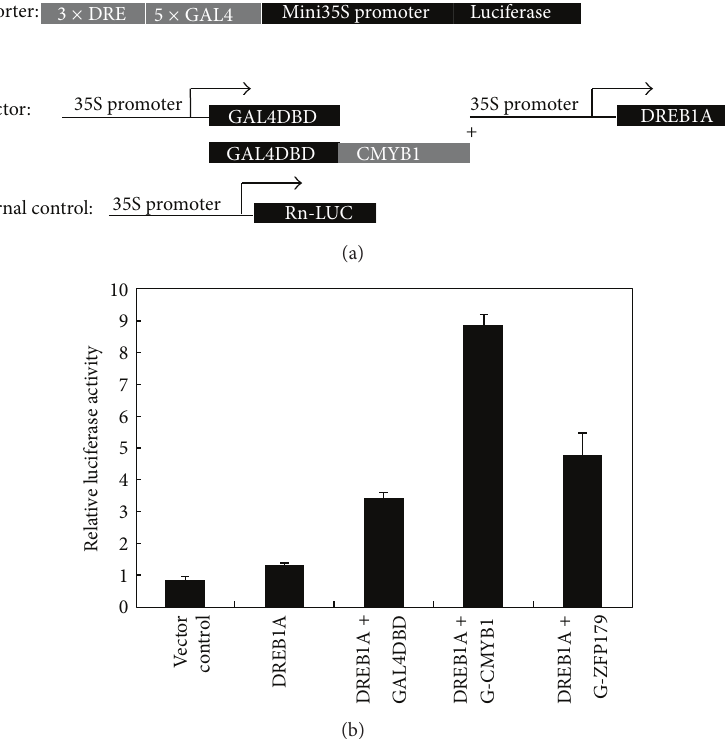
Figure 6: Transcriptional activity analysis of CMYB1 in rice protoplast via dual luciferase reporter assay system. (a) Construction of reporter, effector, and internal control vectors. (b) The luciferase activities. Vector control contained reporter and internal control plasmids; DREB1A contained reporter, internal control, and 35S::DREB1A protein plasmids; DREB1A+GAL4DBD contained reporter, internal control, 35S::DREB1A protein, and 35S::GAL4DBD protein plasmids; DREB1A+G- CMYB1 contained reporter, internal control, 35S::DREB1A protein, and 35S::GAL4DBD- CMYB1 fusion protein plasmids; DREB1A+G-ZFP179 contained reporter, internal control, 35S::DREB1A protein, and 35S::GAL4DBD-ZFP179 fusion protein